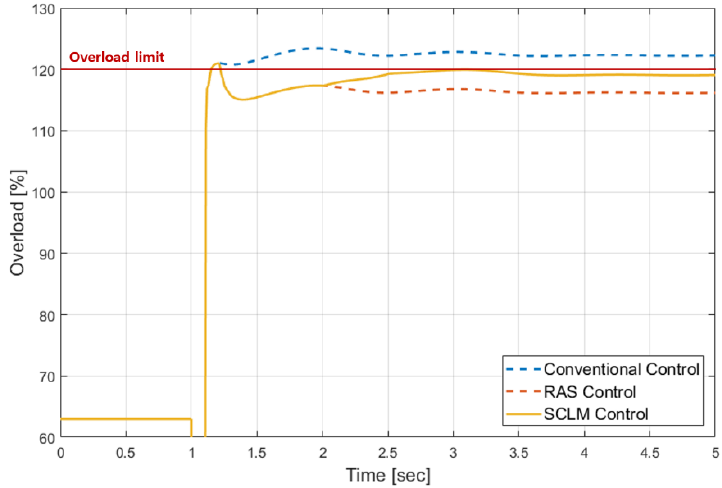
Figure 15. Comparison of HVDC control for overload mitigation in the line overload case.